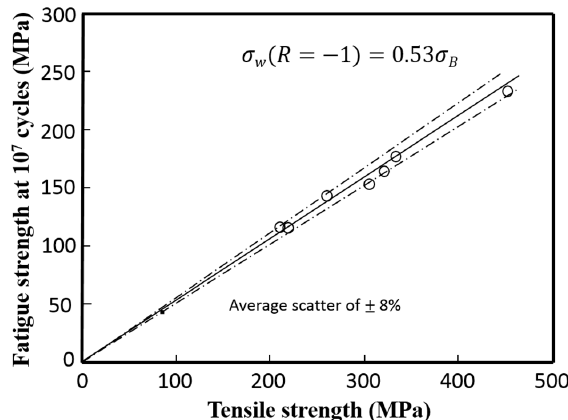
Figure 12. Relationship between the fatigue strength under R = − 1 at 10 7 cycles and tensile strength.